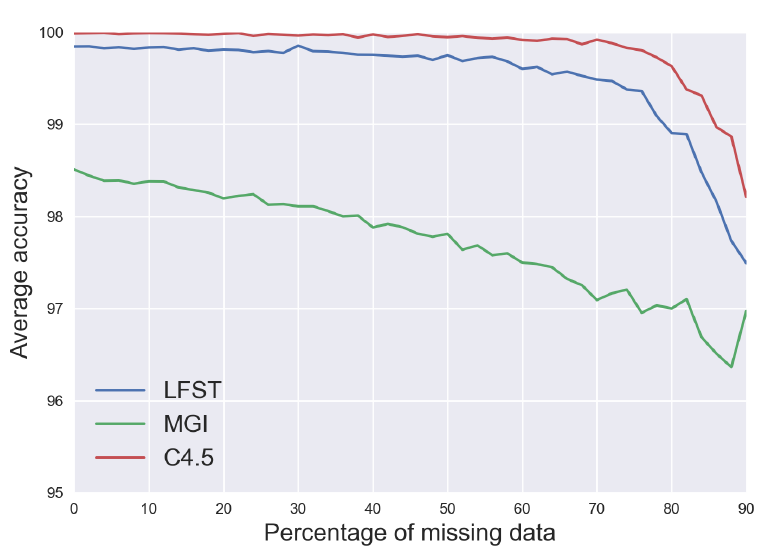
Figure 6. Comparison of the average accuracy in